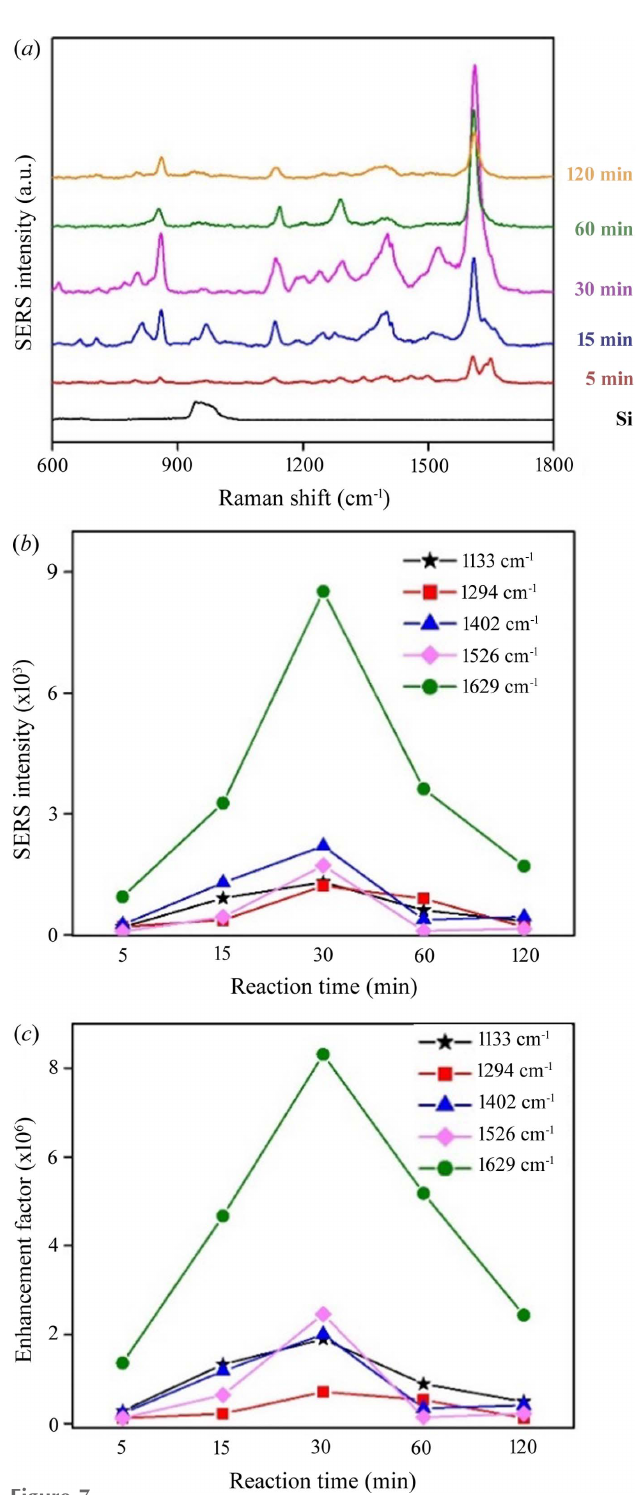
Figure 7 ( a ) Raman spectra of aqueous rhodamine 6G (10 (cid:3) 6 M ) solution for Ag- DNF/Si samples. ( b ) Variation of SERS intensity peak heights and ( c ) enhancement factors among